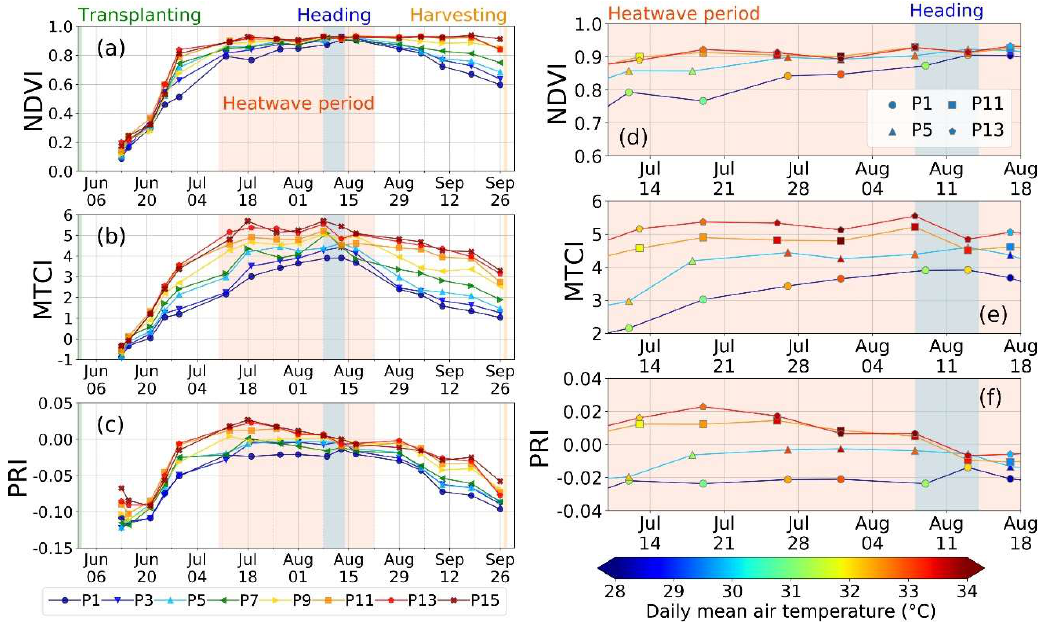
Figure 6. Time series of NDVI, MTCI, and PRI according to different air temperature. ( a )–( c ) Time series of vegetation indices during the whole cultivation period in 2018. ( d )–( f ) Time series of vegetation indices during the heatwave period in 2018. Positions were divided into 16 at equal intervals in each temperature gradient field chamber (TGFC) and they were named as position 1 (P1) ~ position 16 (P16). P1 indicates the time series of vegetation indices exposed to ambient temperature (AT), and P15 indicates the time series of vegetation indices exposed to high air temperature (about AT+2.37 °C). P5 and P11 were averagely higher temperatures as +0.91 and +1.71 °C than AT.